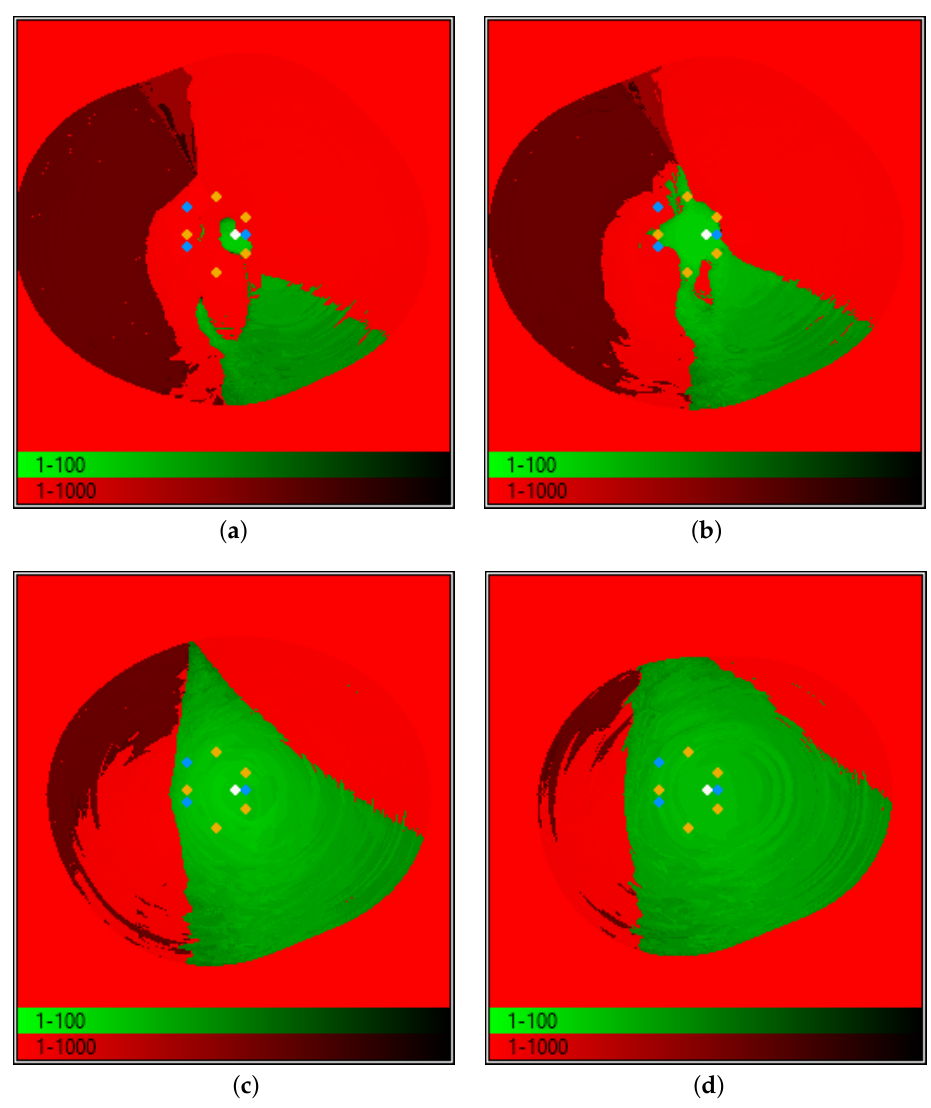
Figure 9. 2D convergence maps of xy sections. The (cid:126) B g and (cid:126) m guess is set at the default, and the z guess is variously assigned: from 8 mm ( a ), to 20 mm ( b ), 60 mm ( c ) and 80 mm ( d ). The z = 40 mm case was already shown in Figure